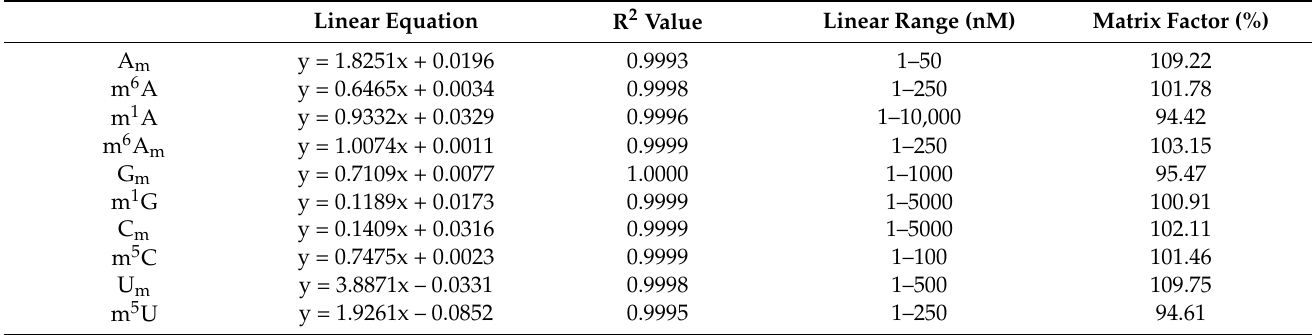
Table 1. Linear equations and matrix effect of A m , m 6 A, m 1 A, m 6 A m , G m , m 1 G, C m , m 5 C, U m and m 5 U in hydrophilic interaction liquid chromatography tandem mass spectrometry (HILIC–MS/MS)